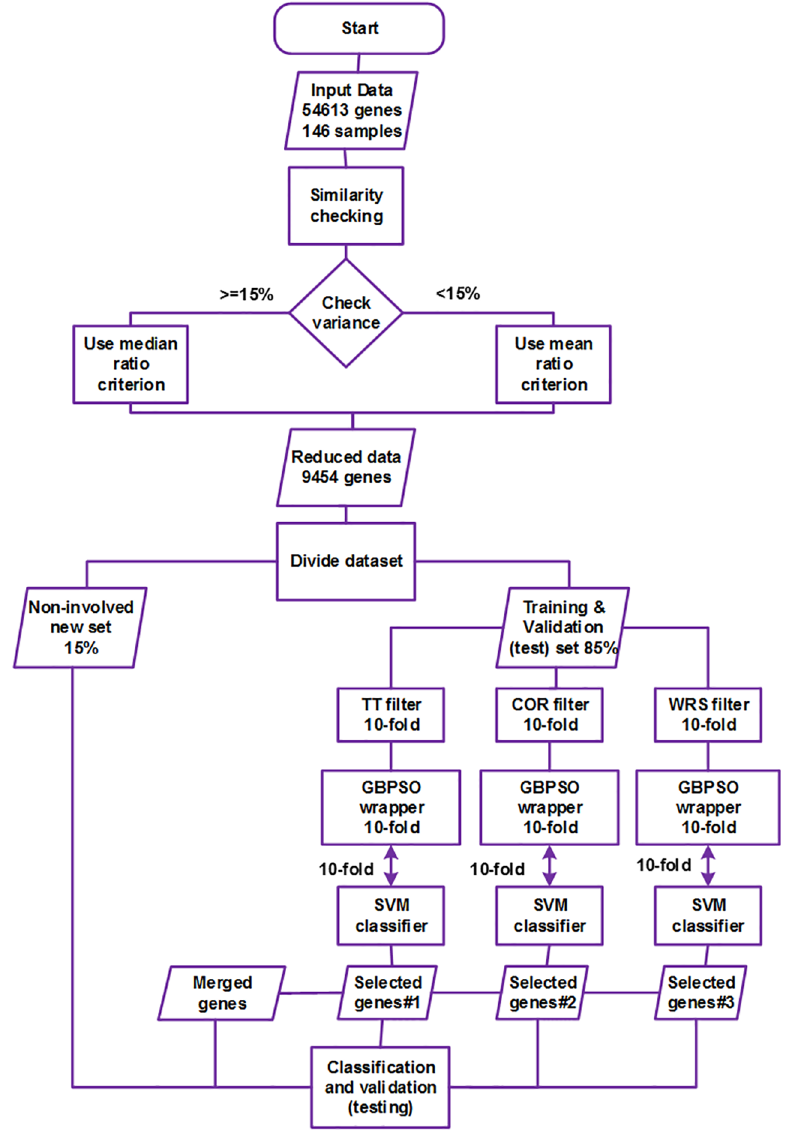
Fig 1. Experimental setup used to select autism-related genes and to perform